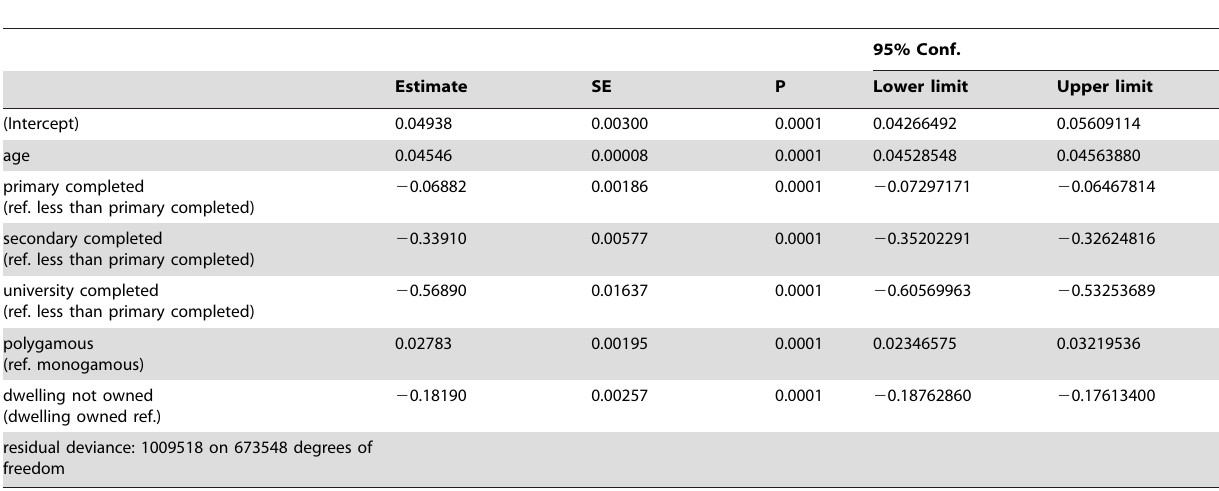
Table 3. GLM on basis of a quasi - poisson error structure, of age, education, type of marriage and ownership of dwelling regressing on the number of children born.